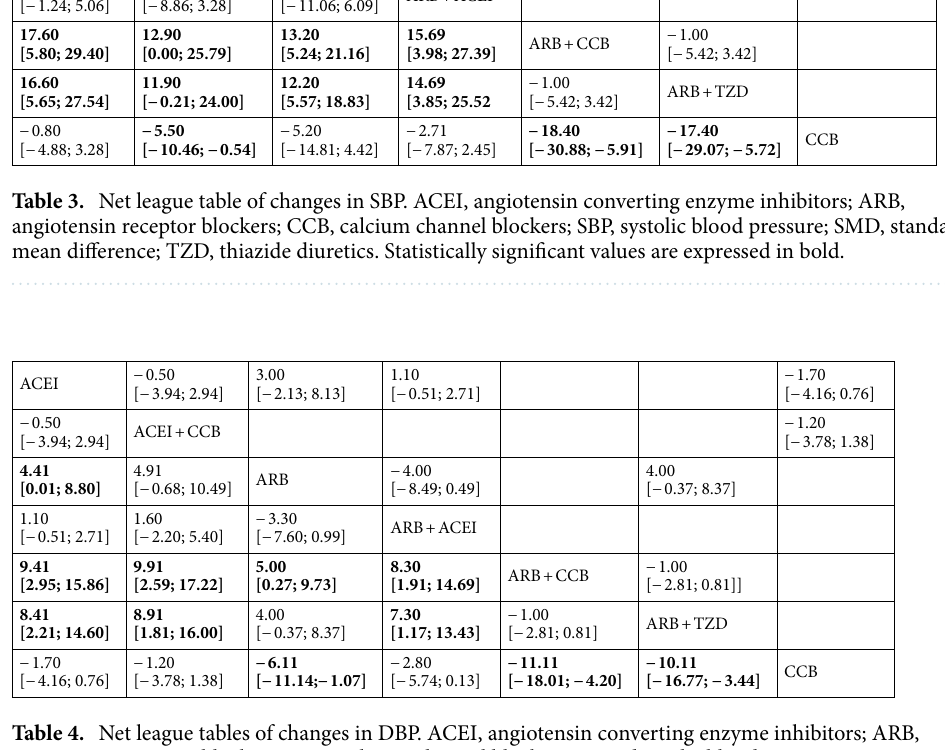
from SUCRA, ARB-based CCB combination had the lowest risk of major CVD events, followed by ACEI-based CCB combination and ACEI-based TZD combination (Table 3), and this may be correlated with the greatest BP reduction effects. Although this study demonstrated comparable reduction of major CVD risk and BP between RASi-based TZD combination and ARB-based CCB combination, the evidences suggest superior benefits of RASi-based CCB on prevention of cardiovascular death over RASi-based TZD in hypertensive patients with high risk for major CVD events, indicating potential advantage of ARB-based CCB combination regimen in non- dialysis CKD patients 32 . Moreover, considering that the diuretic efficacy of TZD worsens with decreased renal function 33 , RASi-based TZD combination may not be a promising choice for in patients with advanced CKD. One of the concerns associated with RASi treatment is elevated risk of hyperkalemia 1,10 . Hyperkalemia induces cardiac arrhythmia, which consequently increases the risks of hospitalization and sudden cardiac death 10 . Both JNC8 and KDIGO guidelines restrict any combination of ACEI, ARB and direct RI in non-dialysis CKD patients based on the strong evidences of increased harm from hyperkalemia and acute kidney injury over cardiovascu- lar and renal benefits 1,10 . Nonetheless, no significant difference in the risk of hyperkalemia was noticed among RASi-based antihypertensive treatment regimens, except RASi-based SPR combination treatment, when com- pared to the combination regimen of ARB with CCB. Interestingly, similar hyperkalemia risk was observed in concomitant administration of ACEI and ARB combination (OR 0.38; 95% CI 0.03–4.94) and non-RASi-based antihypertensive treatment including CCB monotherapy (OR 0.06; 95% CI 0.00–2.26), CCB and BB combina- tion (OR 0.84; 95% CI 0.22–3.17) and CCB and TZD combination (OR 1.28; 95% CI 0.37- 4.42) in this study. Although the evident mechanism for similar hyperkalemia risks regardless of the diverse combination of antihy- pertensive agents is yet to be determined, disease-specific factor may have superior influences on hyperkalemia risk over RASi use in CKD patients 34 . Renal insufficiency itself is a compelling risk factor of hyperkalemia as the hyperkalemia incidence and severity increase with CKD progression, and a previous study revealed that the degree of renal insufficiency manifested by elevated serum creatinine level was the strongest positive correlation factor with serum potassium over other contributing factors such as diabetes, RASi use, and age 35 . However, the